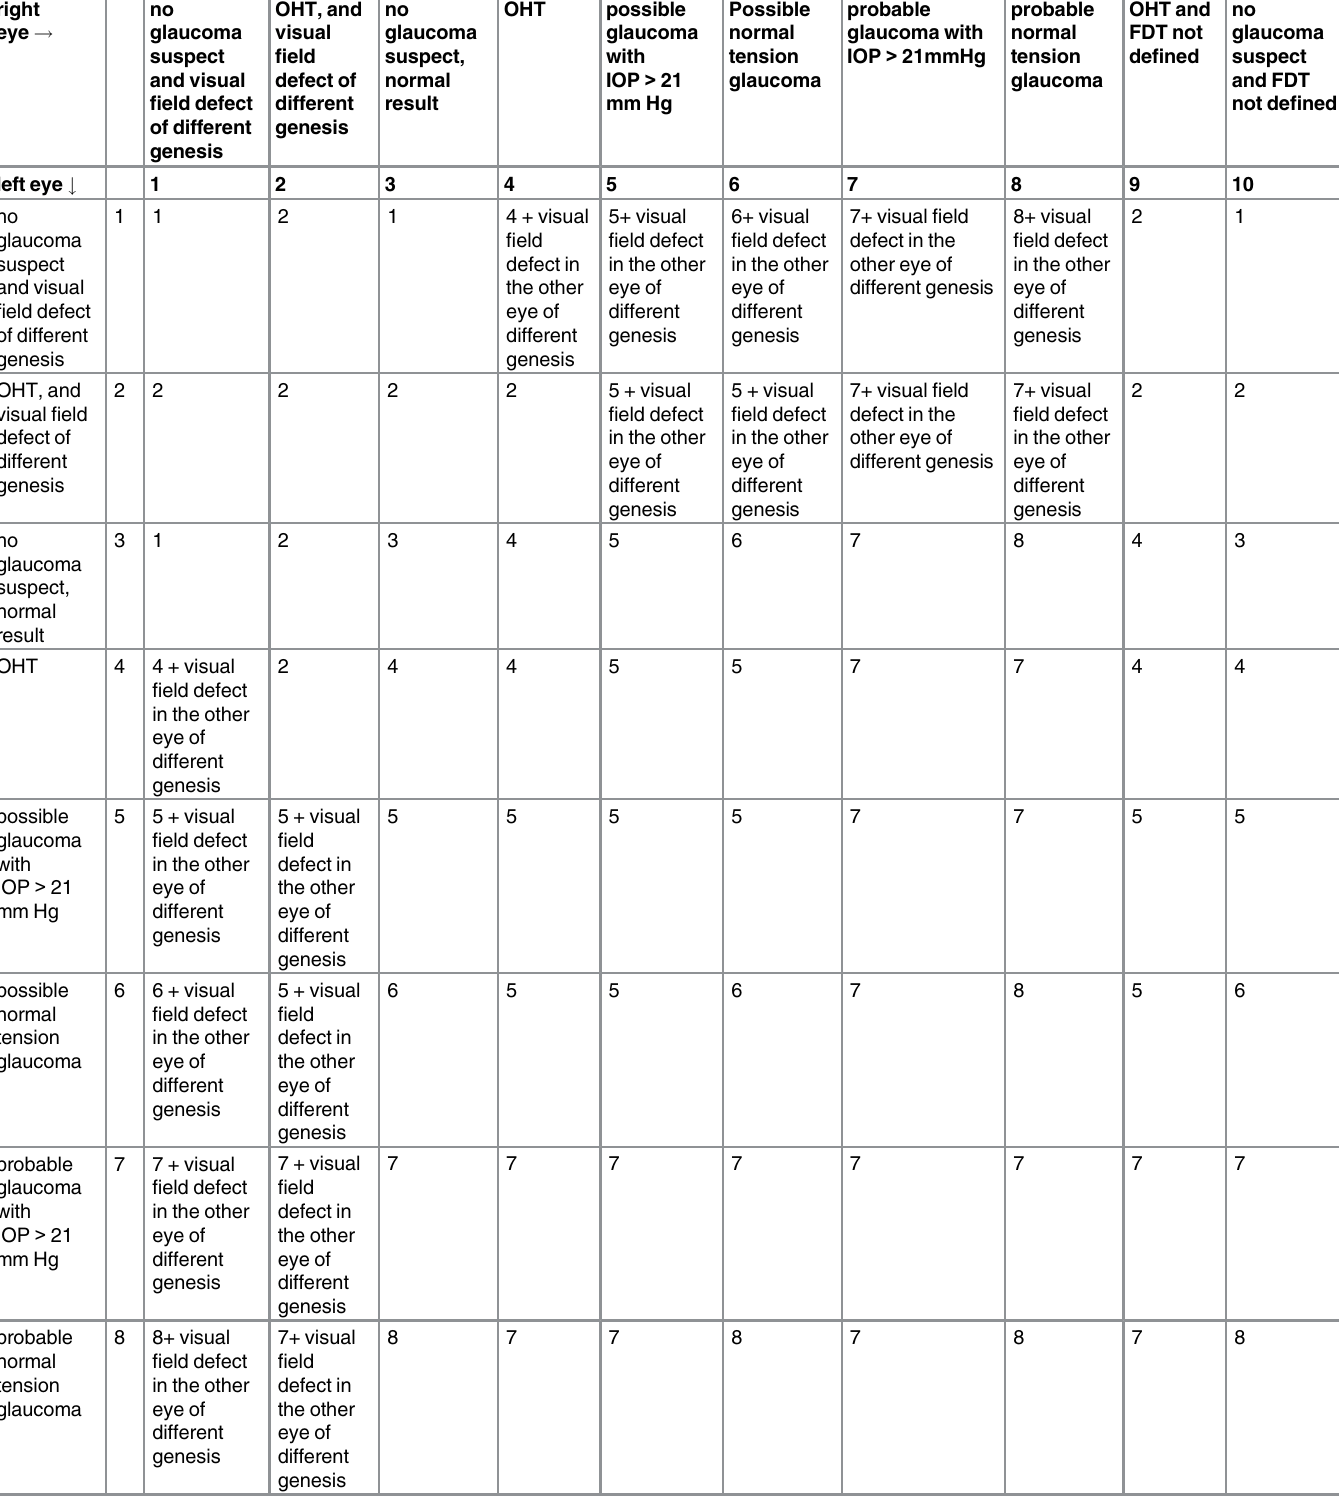
Table 2. Cross tabulation for diagnosing individuals on categorization of left and right eyes. Numbers are defined in the marginals and final diagnoses of the individuals are given in cells. right eye